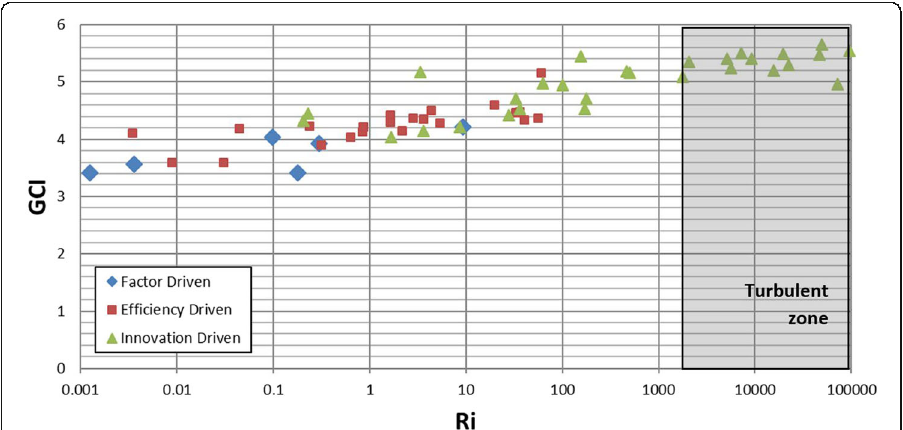
Fig. 11 Relationship between GCI ’ s Factor, Efficiency and Innovation metrics and the innovation metric, R